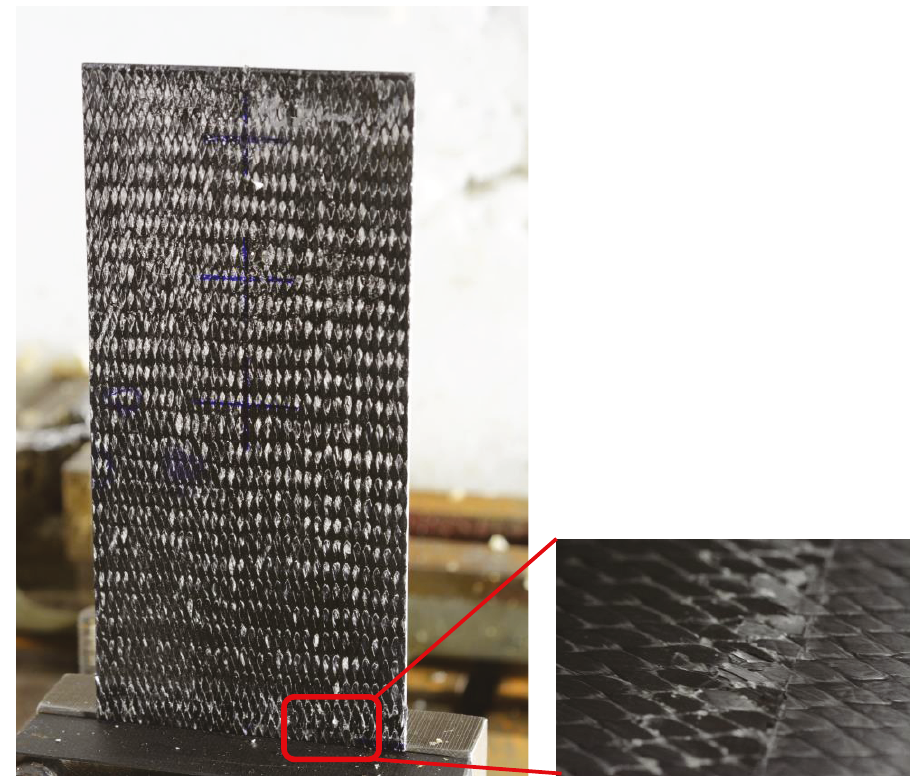
Figure 11: Damage topography of target panel under impact at position of 90%